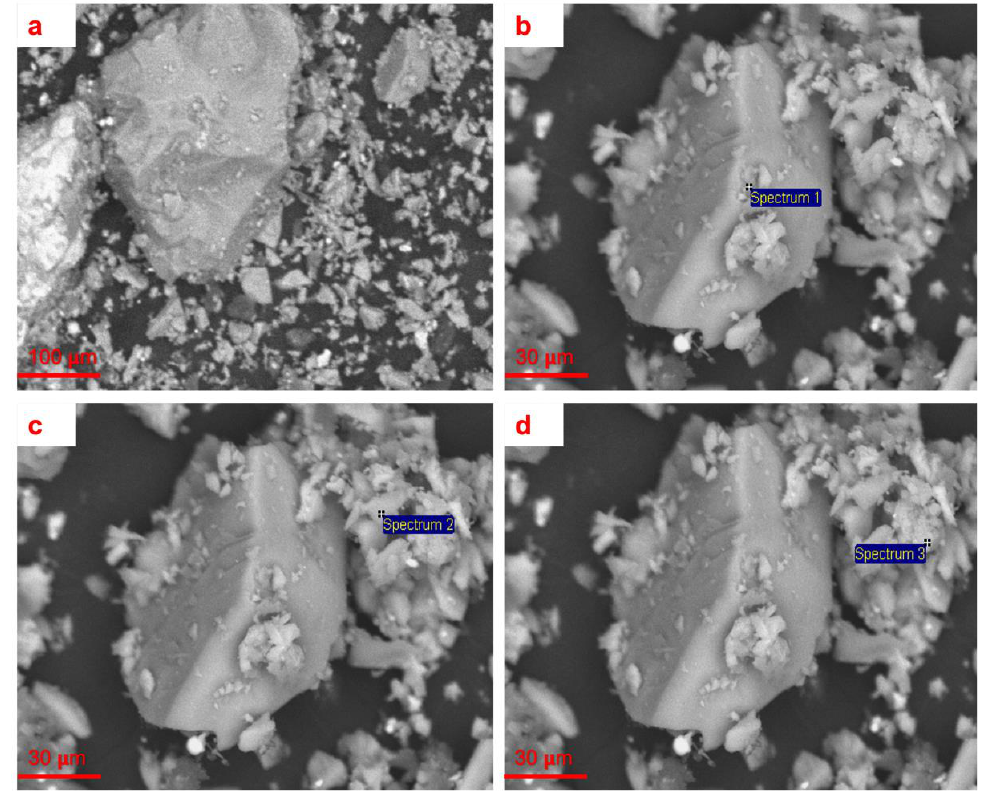
Figure 13. SEM images of the leached residue under additives conditions at ( a ) low magnification and ( b – d ) high magnification after 120 min.